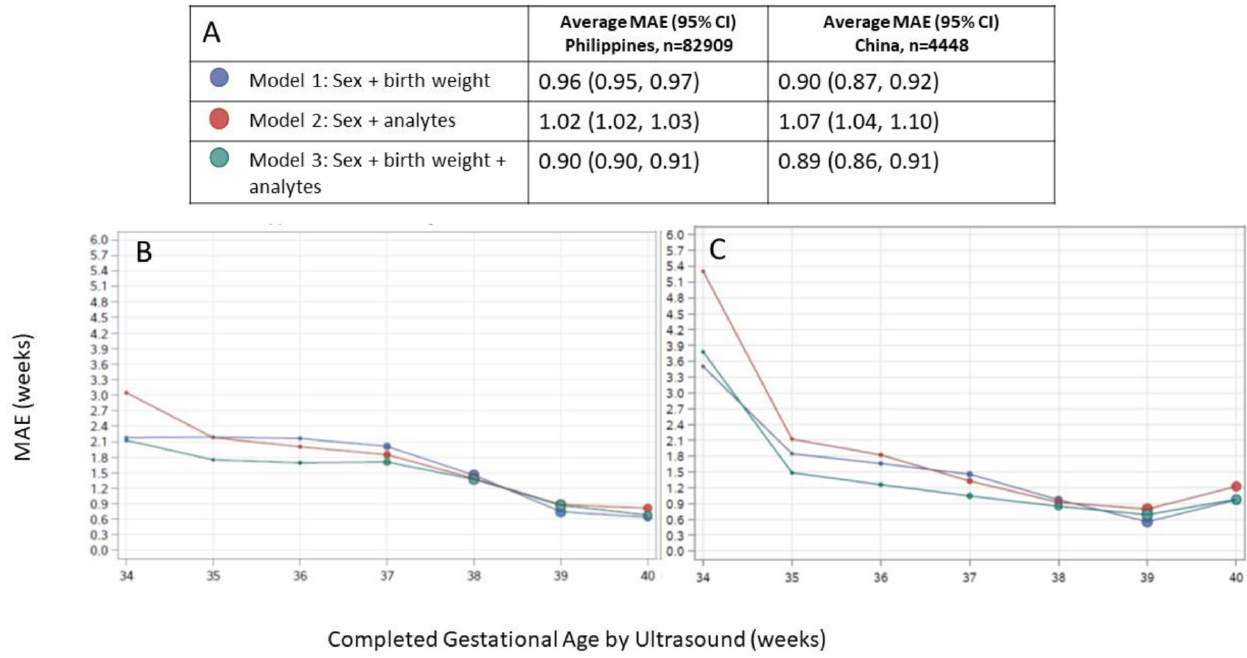
Figure 3. Agreement between algorithmic gestational age estimations compared to ultrasound-assigned gestational age. ( A ) Legend, and overall MAE (95% CI) for each model applied to data from the Philippines and China. Dot size in plots is proportional to sample size in each gestational age category. Performance of each model by ultrasound-assigned gestational age when applied to data from ( B ) the Philippines ( C ) China. MAE, mean absolute error (average absolute deviation of observed vs. predicted gestational age in